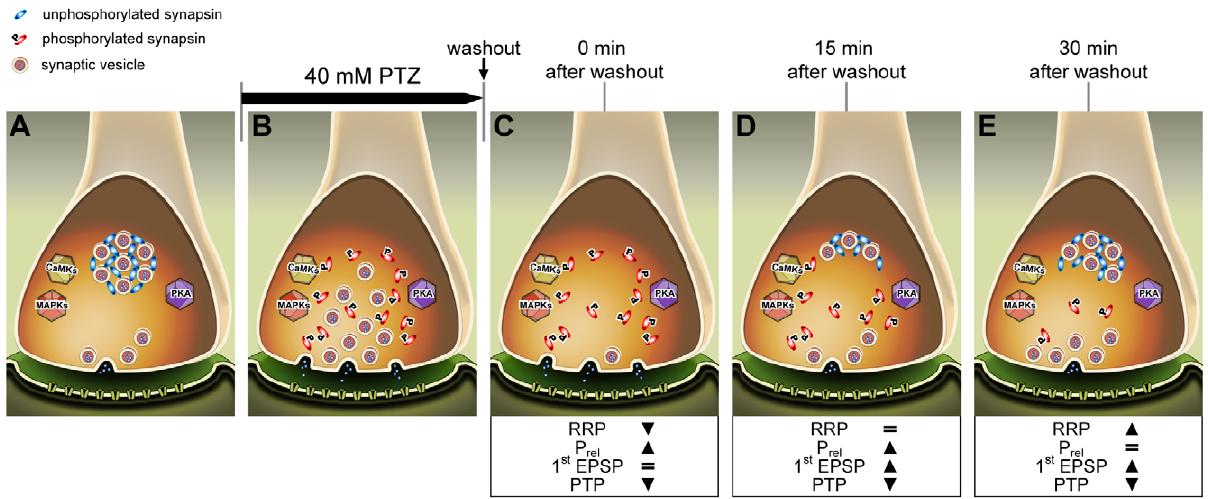
Figure 10. Epileptiform activity increases the synapsin phosphorylation status, thus leading to an altered basal synaptic transmission. Hypothetical cascade of intracellular events occurring at presynaptic terminal during epileptiform activity. At resting potential (A), unphosphorylated synapsin tethers small vesicles into the RP. Prolonged paroxysmal activity (B) that induces the activation of several kinase pathways and promotes vesicle mobilization through synapsin phosphorylation, leads to a very large release of neurotransmitter (C). Afterwards, although recycled vesicles start to reorganize themselves into synaptic pools (D), the enhanced phosphorylation status of synapsin compromises pool maintenance, thus increasing the number of free vesicles that are ready to be released